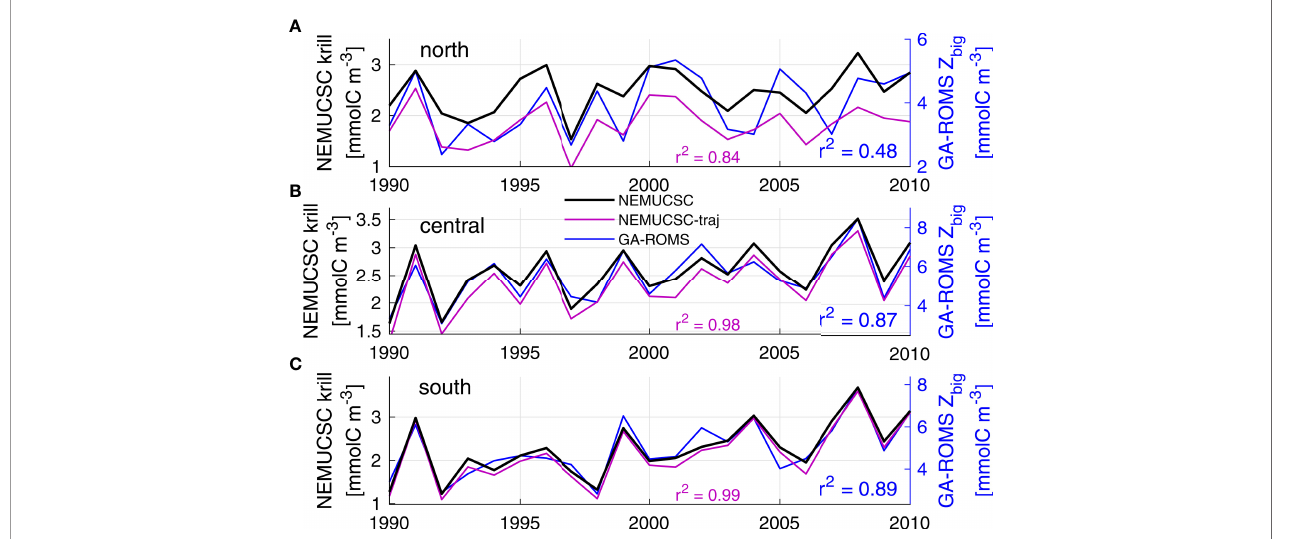
FIGURE 4 | Validation of GA-ROMS interannual variability against NEMUCSC. Panels display yearly time series for each hotspot for NEMUCSC (black), NEMUCSC- traj (purple, same y-axis) and GA-ROMS (blue), obtained by averaging the hotspot region for the peak months each year (see Figure 3 ): (A) north 40.4-42.8°N July- August, (B) central 36.3-38.9°N June-July, (C) south 34.5-36°N May-June, all up to 150 km offshore. Correlations against NEMUCSC are given for NEMUCSC-traj (purple) and GA-ROMS